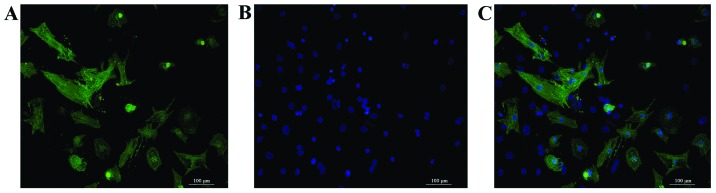
The morphology and identification of cardiomyocytes. (A) Green fluorescence represents cardiomyocytes with α-actinin inmmunofluorescence staining. (B) Blue fluorescence represents cell nucleus detected by Hoechst 33258 staining. (C) Merged inmmunofluorescence staining. The normal cultured cardiomyocytes were positive for α-actinin inmmunofluorescent staining. The negatively stained α-actinin inmmunofluorescent cells indicated the contaminating fibroblasts.